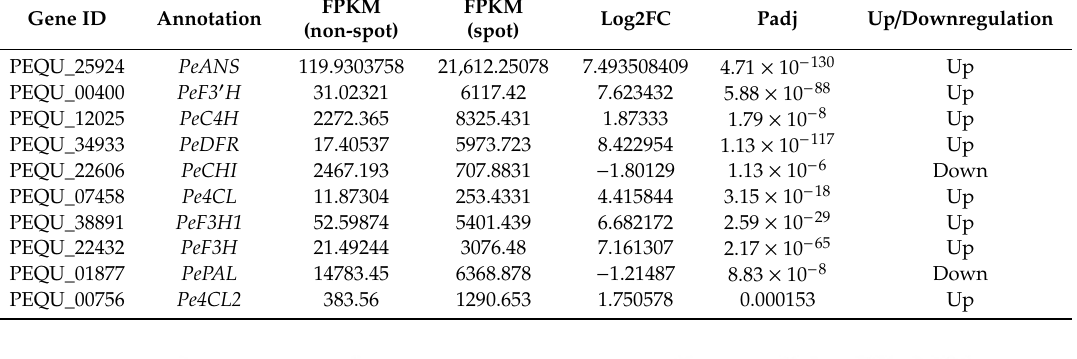
Table 1. Putative anthocyanin structural genes identified from di ff erentially expressed genes (DEGs).